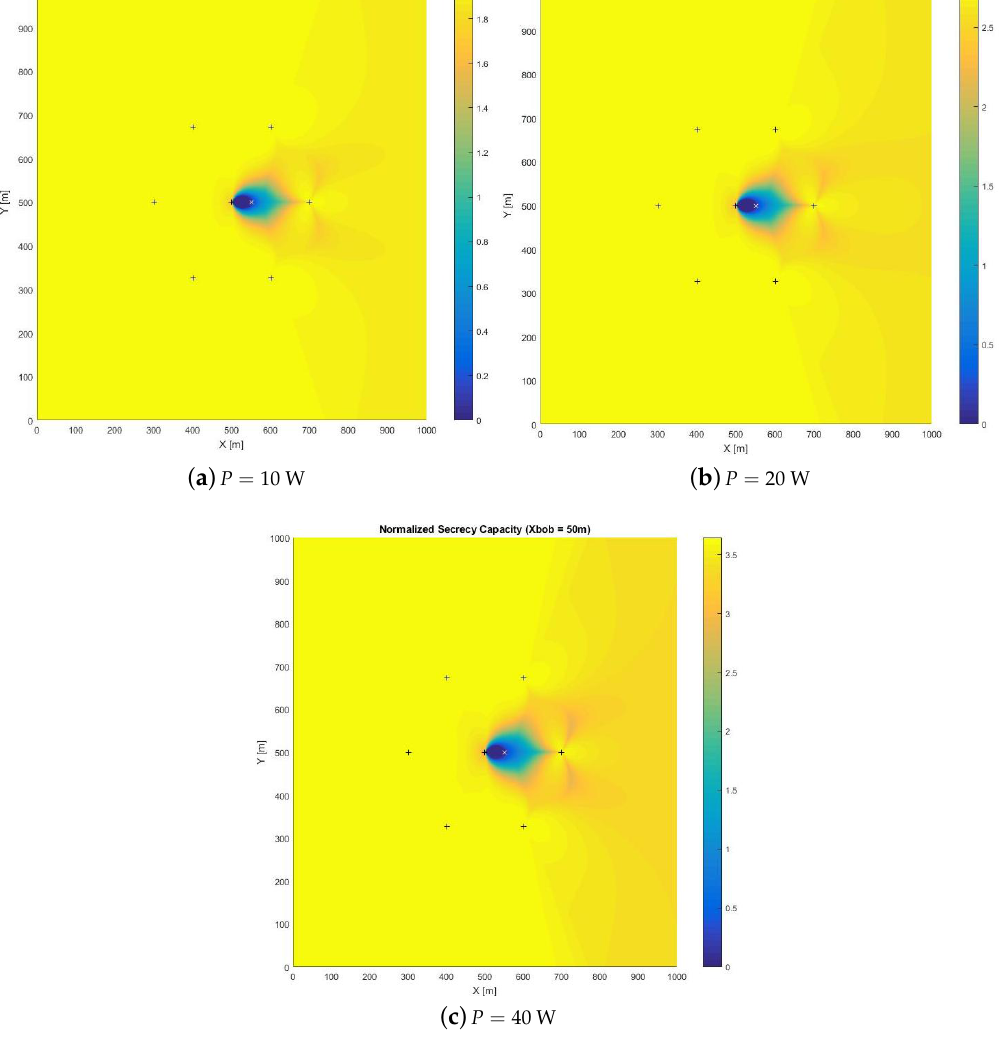
Figure 3. Secrecy capacity geographical distribution when Bob’s distance from Alice is 50